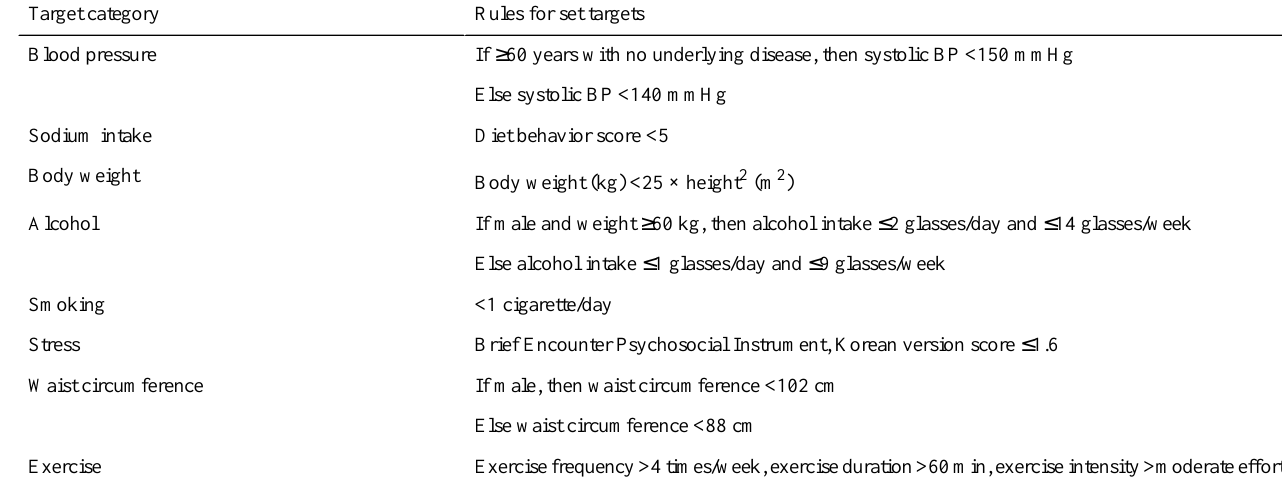
Table 4. Rules of setting targets of the HMA [20,22].